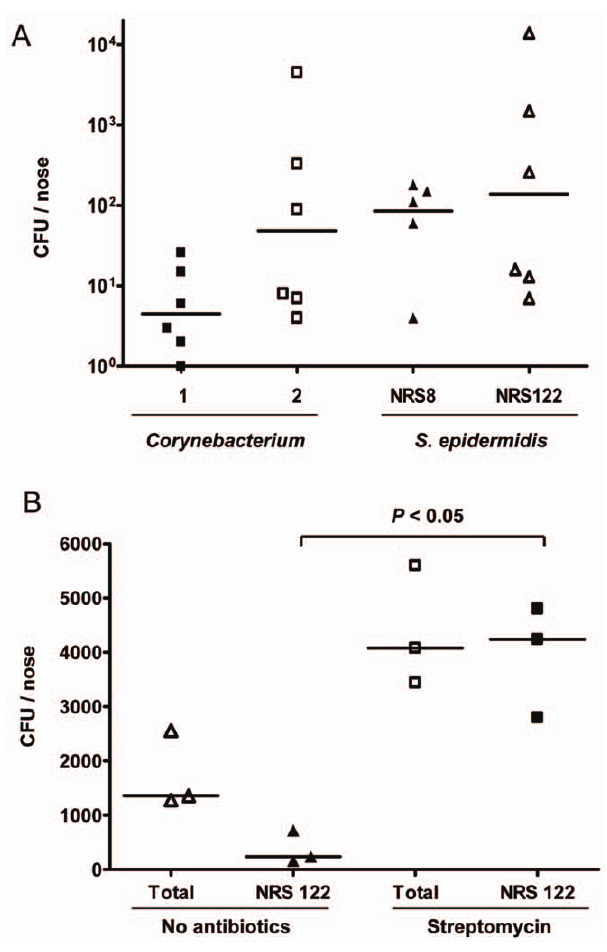
Figure 1. Optimizing conditions for bacterial interference. (A) Efficacy of nasal colonization by four strains of bacteria. CD1 mice were inoculated with 1 6 10 9 CFU on d1 and 4. Nasal CFU was enumerated 3 days after the last inoculation. Corynebacterium spp. 1 versus NRS122: p , 0.05. (B) Effect of oral streptomycin treatment on S. epidermidis NRS122 nasal colonization. Mice were given streptomycin water for 7 days, then inoculated with a streptomycin-resistant strain of NRS122 daily for 3 days. Nasal CFU were harvested 3 days later. Shown are total CFU or CFU from streptomycin plates. Bars in the graph represent the median CFU of each experimental group.